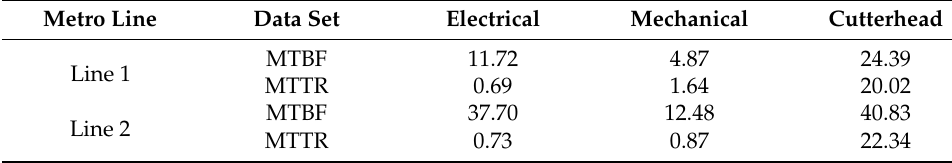
Figure 11. Availability/Unavailability of EPBM/subsystems in Lines 1 and 2. Table 8. Comparison of MTBF and MTTR of subsystems in Lines 1 and